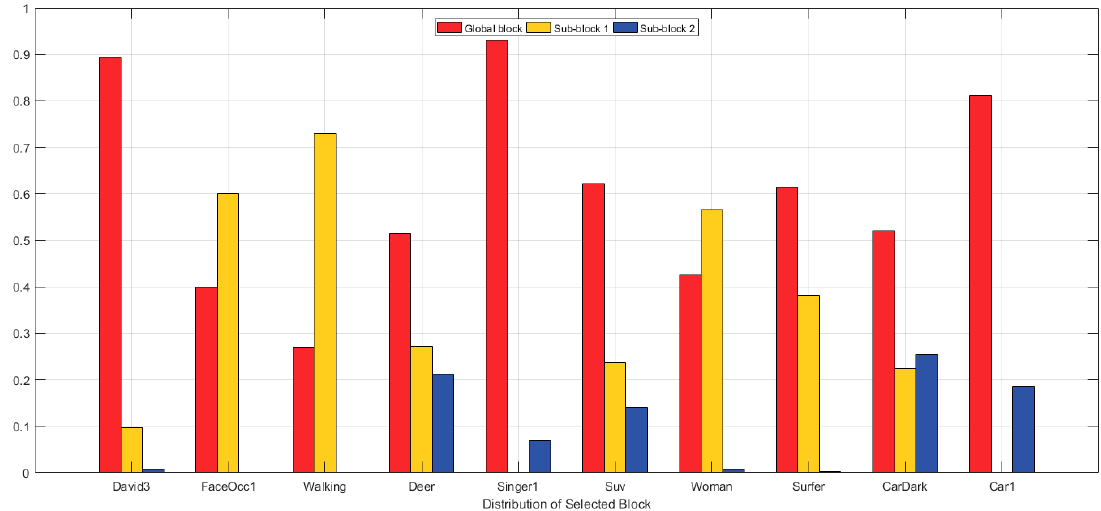
Figure 10. Distribution of selected blocks according to the image sequence. The y-axis represents the probability of each block being selected.